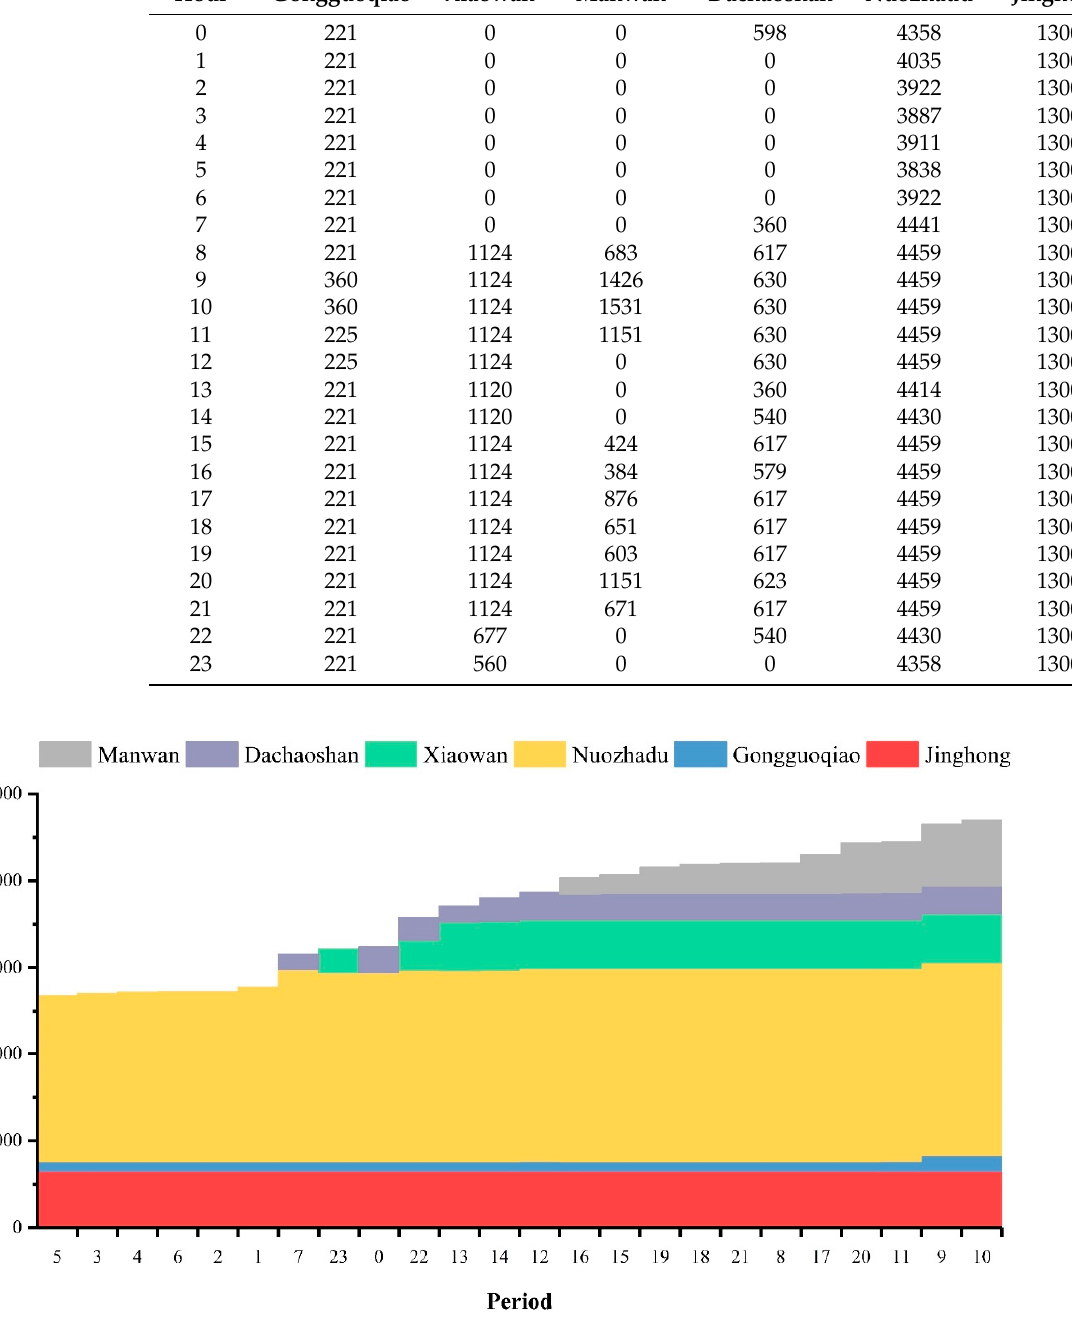
Figure 7. Hourly power generations of plants (in ascending order of load).